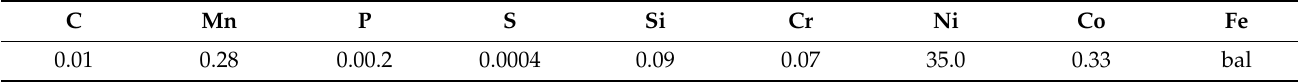
Table 1. Chemical composition of Invar alloy